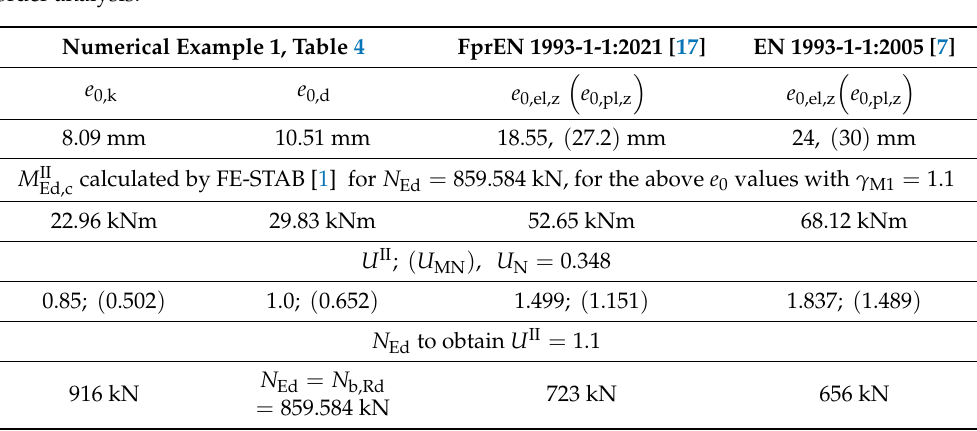
, U II and ( U MN ) of the second- Ed,c